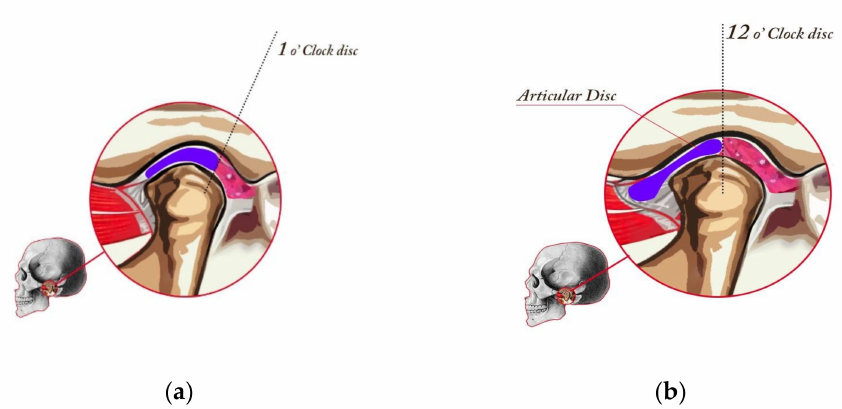
Figure 1. Healthy joint (stage I in the Piper classification), placed in CR, and drawing of a cut at the medial pole. Posterior band of the disk aligned with the schematic 1 o’ clock position ( a ) and minor change in the disk position, which constitutes the Piper IVa classification. The joint is in CR, and the drawing at the medial pole of the TMJ. In class IV, the disk slips in the anterior direction when opening the jaw ( b